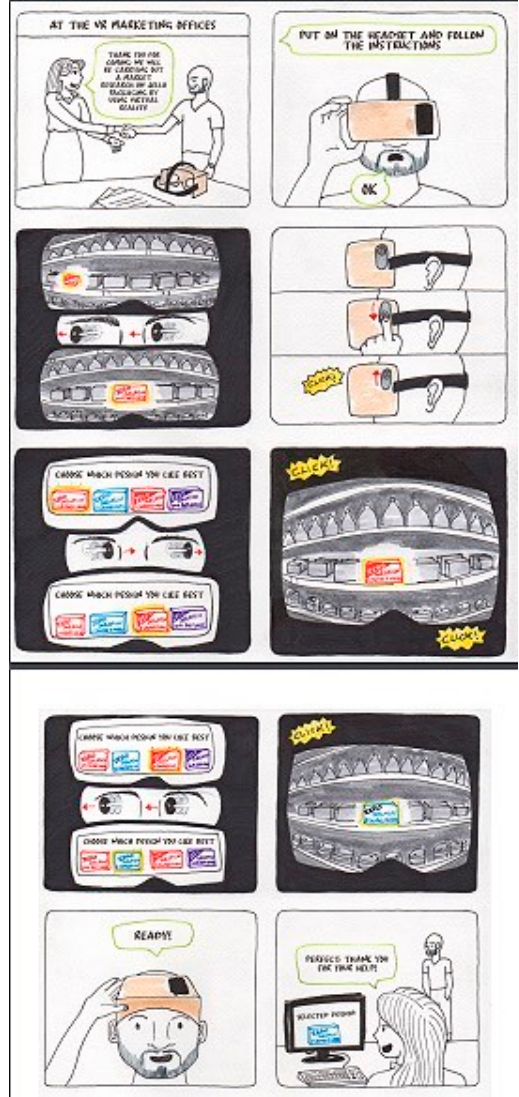
Figure 1. Storyboard made to represent the idea and the future prototype interaction